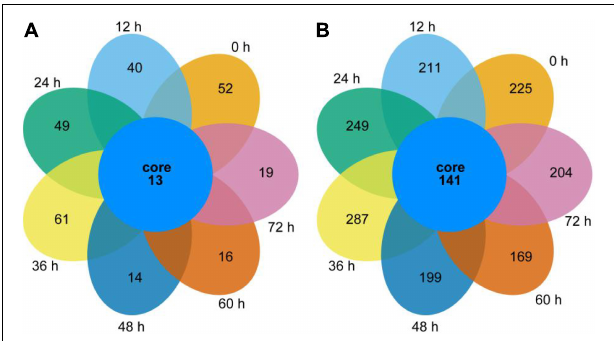
FIGURE 2 | Bacterial and fungal Venn diagrams of the non-post fermented Shuidouchi. (A) Venn diagrams of the bacterial OTUs, (B) Venn diagrams of the fungal